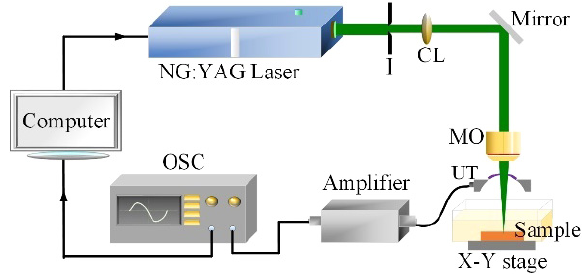
Fig. 3. Schematic diagram of the simultaneous PA/US imaging system. CL — collimating lens; MO — microscope objective; OSC —